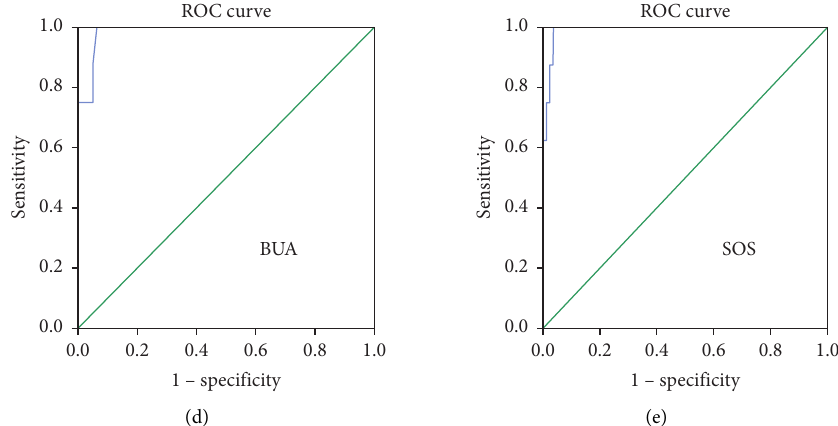
Figure 1: Receiver operating characteristic (ROC) curve showing the ability of handgrip strength (kg), skeletal muscle mass index (kg/m 2 ), fat-free mass index (kg/m 2 ), broadband ultrasonic attenuation (dB/MHz), and speed of sound (m/sec) to predict osteosarcopenia (T- score ≤ − 2.5 and appendicular skeletal muscle mass index ≤ 5.7kg/m 2 ) in obese participants (BFP ≥ 32%, OSO, N � 8), plotted against obese participants without osteosarcopenia (T-score > − 2.5 and appendicular skeletal muscle mass index > 5.7kg/m 2 , BFP ≥ 32%, OB, N � 82). BFP: body fat percent, OSO: osteosarcopenic obese; OB: